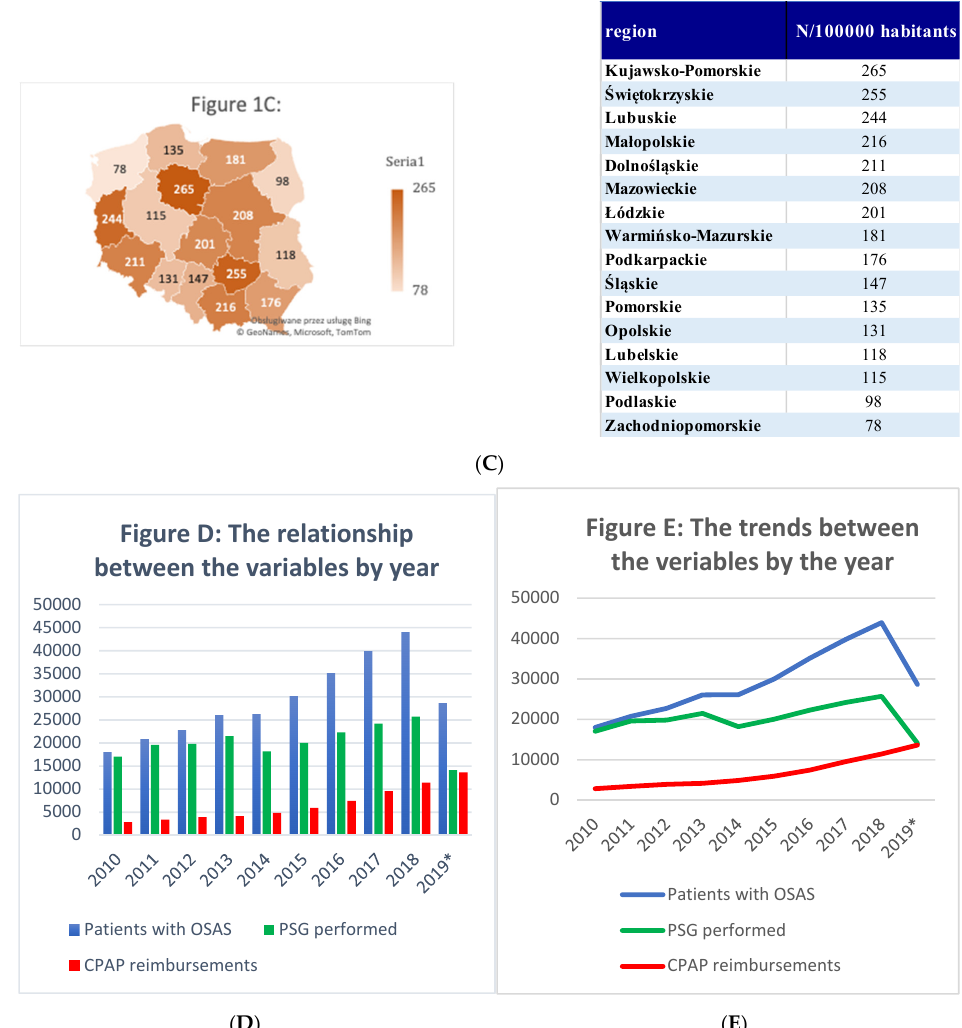
Figure 1. Number of patients with a diagnosis of obstructive sleep apnea syndrome (OSAS), the number of polysomnographies, and the number of reimbursements of positive airway pressure (PAP) treatment in regions of Poland from 2010 to 2019. ( A ) Number of patients with a diagnosis of obstructive sleep apnea syndrome during 2010–2019 in all regions of Poland. ( B ) Number of polysomnographies during 2010–2019 in all regions of Poland. ( C ) Number of reimbursements by the National Health Service for the positive airway pressure (PAP) therapy for obstructive sleep apnea. ( D , E ) The relationship and the trends between the number of patients with an OSAS diagnosis, the PSG performed, and PAP reimbursements for the years 2010–2019. * 2019 from January to June.